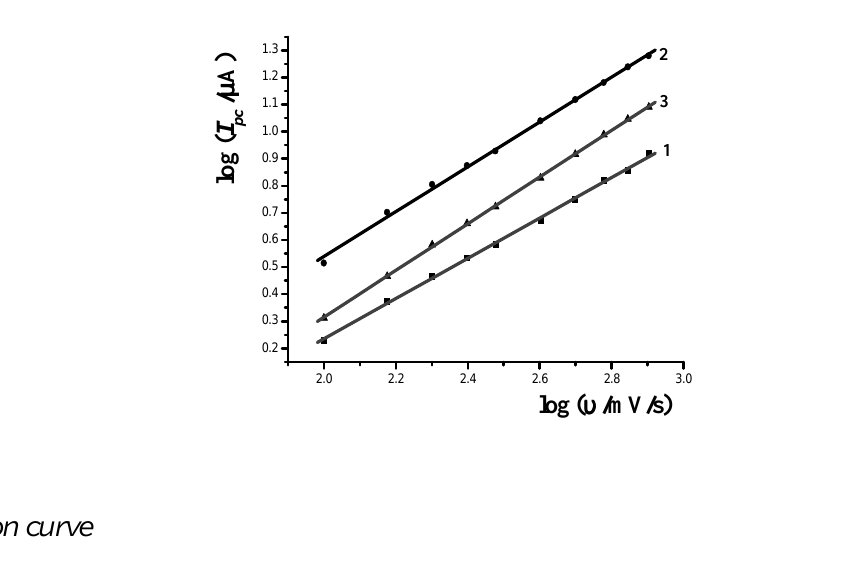
Figure 4. Plots of cathodic peak current vs. log υ on bare Au electrode (1), ssDNA/MAA/Au (2) and dsDNA/MAA/Au electrode (3).